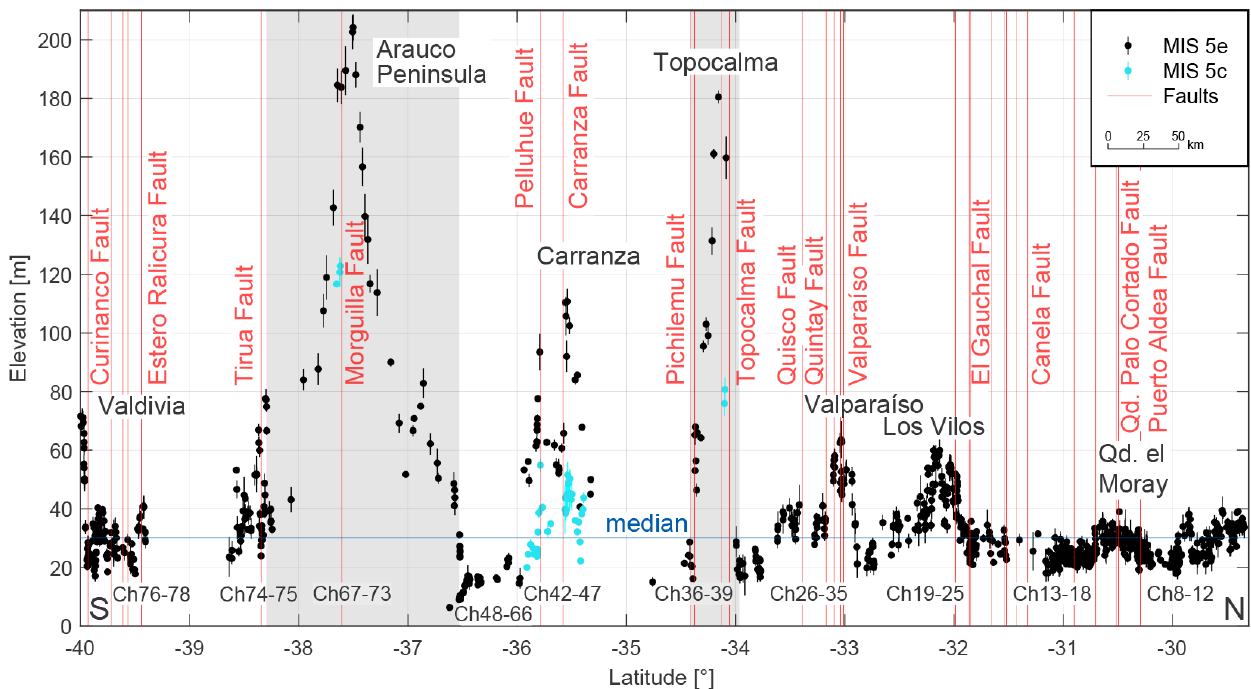
Figure 9. Measured shoreline-angle elevations of MIS 5e and 5c terraces in central Chile (Ch). Extensive faulting coincides with various high terrace elevations of the last interglacial highstand north of Los Vilos, near Valparaíso, at Topocalma, Carranza, and near Valdivia. The most pronounced long-wavelength change in terrace elevation occurs on the Arauco Peninsula with maximum elevations over 200m and minimum elevations below 10m north of Concepción. Qd. – Quebrada. Median elevation: 30.1m. For location see Fig.